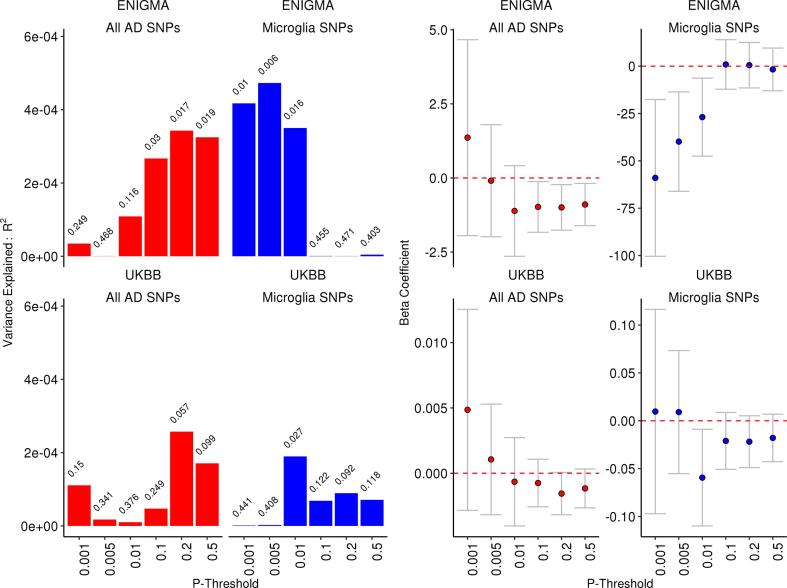
All AD-RPS (SNPs across whole genome) regressed on hippocampal volume (across whole genome; red) and microglia AD-RPS (SNPs within 56 microglia-mediated immunity genes (Sims et al., 2017; blue)). Left Y-axis = R2; Right Y axis = beta coefficients (+/− 95% confidence), X-axis = P-Threshold of AD-RPS. All AD-RPS are performed after the removal of the APOE and MHC loci. P values are annotated above each bar that denotes variance explained (R2) at each AD-RPS/P – threshold.